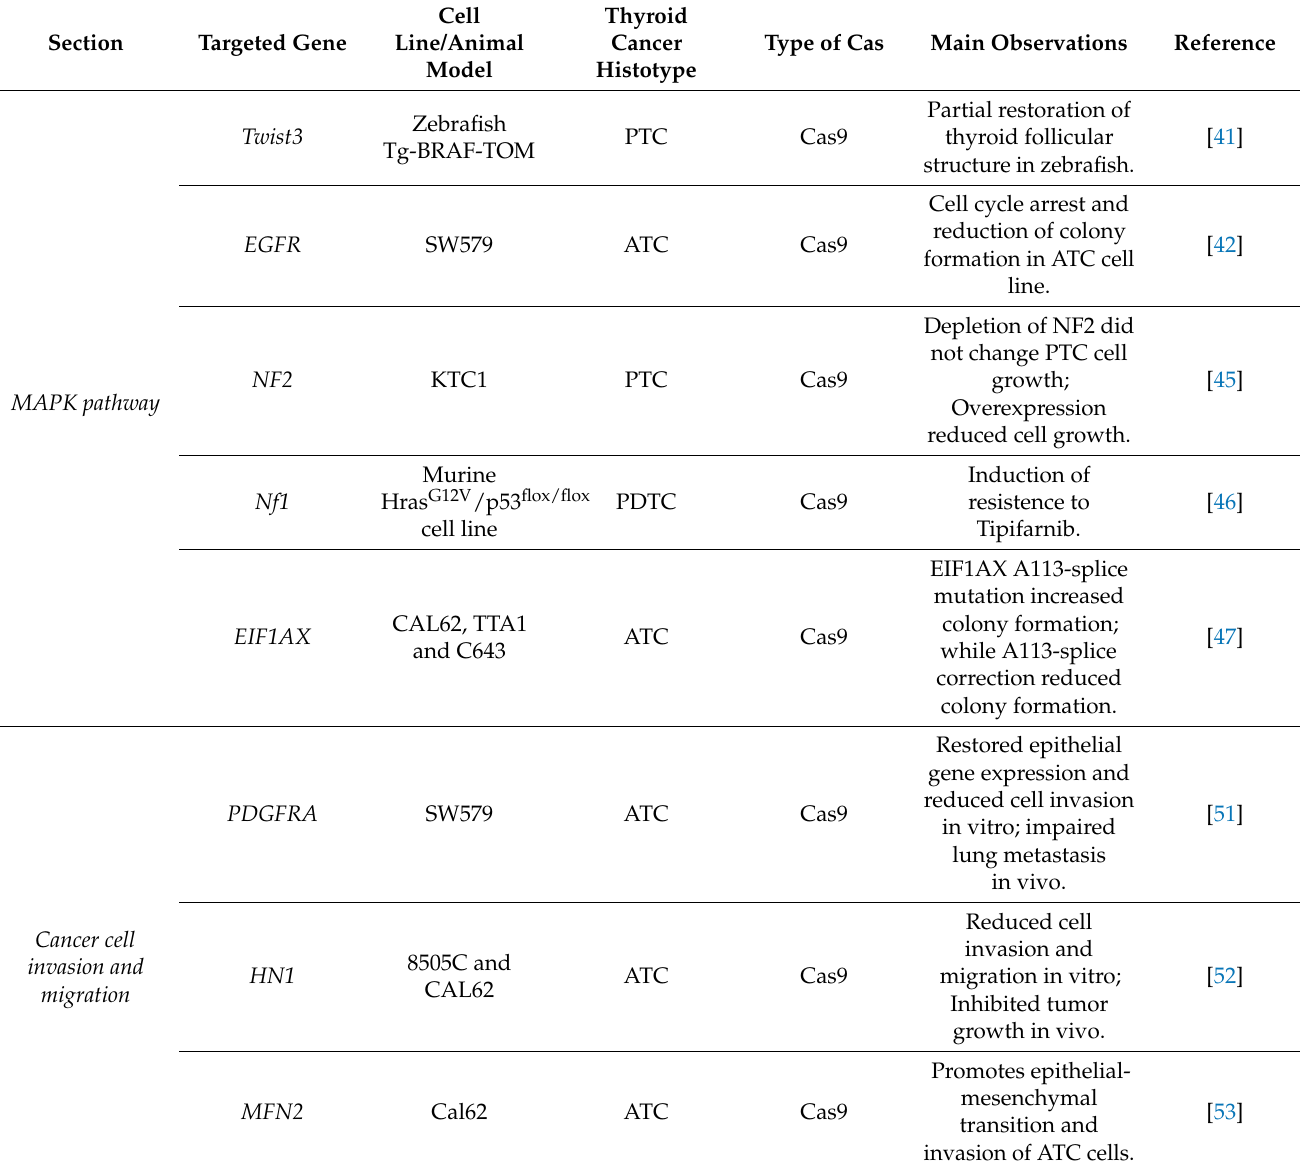
Table 3. Applications of CRISPR/Cas9 gene editing in thyroid